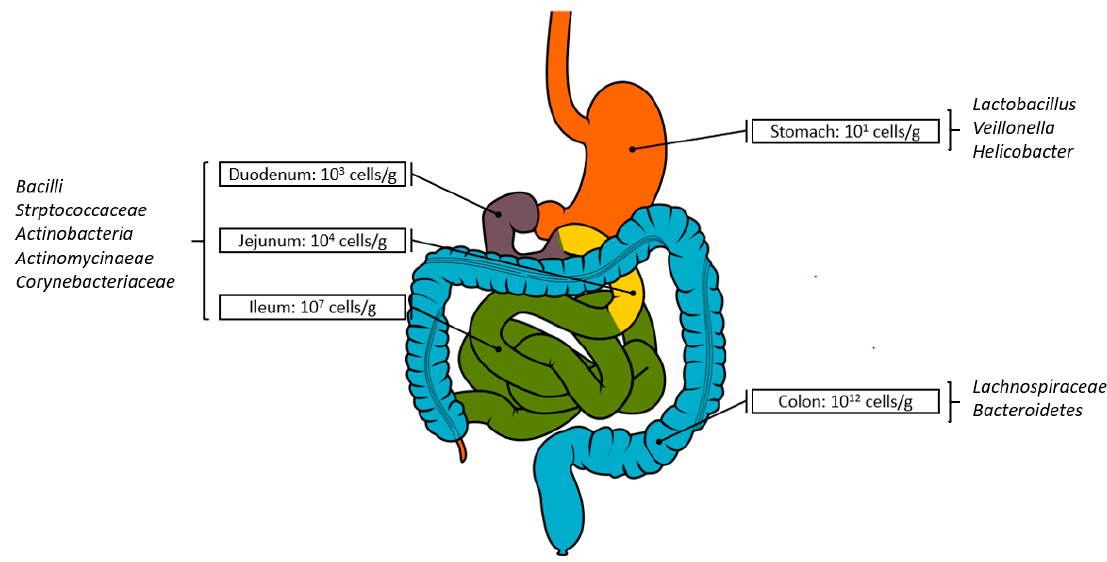
Figure 1. Variations in bacterial number and composition across the length of the gastrointestinal tract (GIT). Image: Olek Remesz (wiki-pl: Orem, commons: Orem) (https: // commons.wikimedia.org / wiki